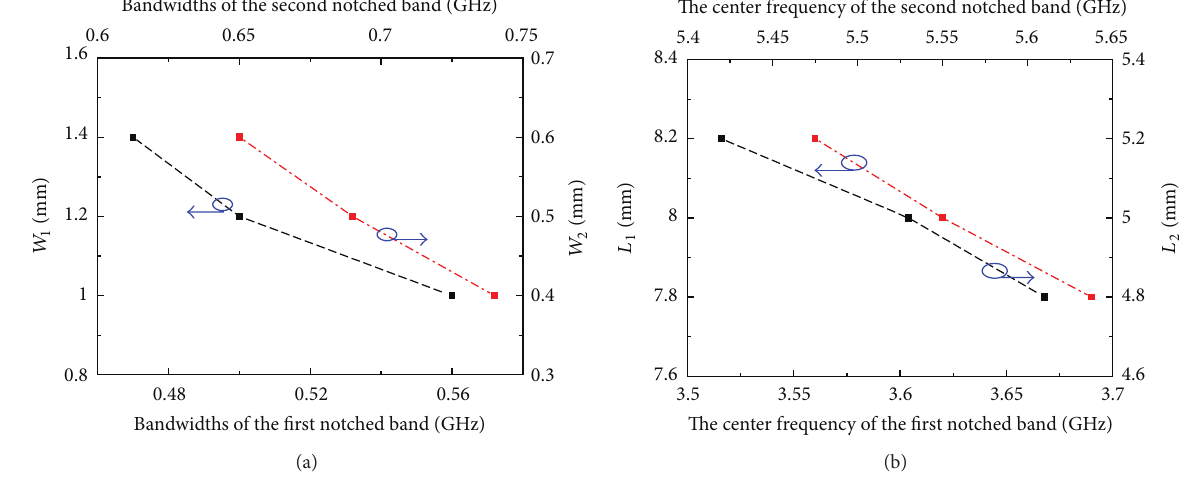
Figure 7: Detailed effects of the parameters of M-EBG on the notched bands: (a) 𝑊 1 and 𝑊 2 (b) 𝐿 1 and 𝐿 2 .